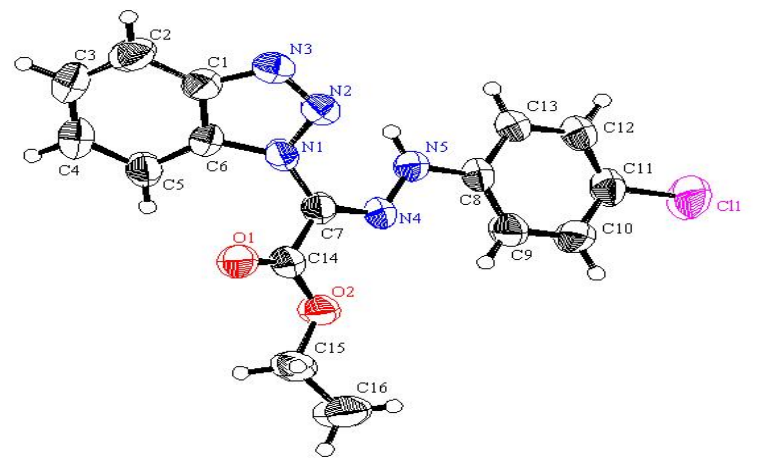
Figure 3. ORTEP drawing of 4b .